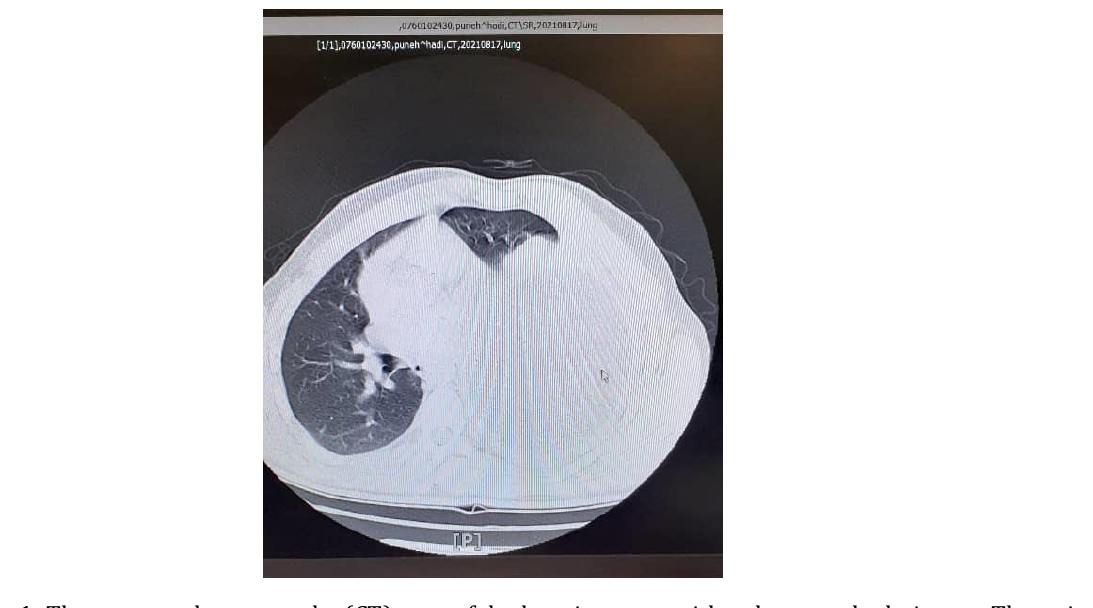
Figure 1: The computed tomography (CT) scan of the lung in a man with pulmonary hydatic cyst. Thoracic CT-scan shows an atelectasis of the upper lobe of left